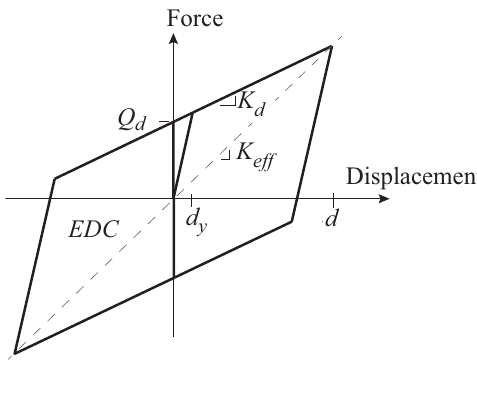
Figure 3. Bilinear horizontal force-displacement characterization of a seismic isolation